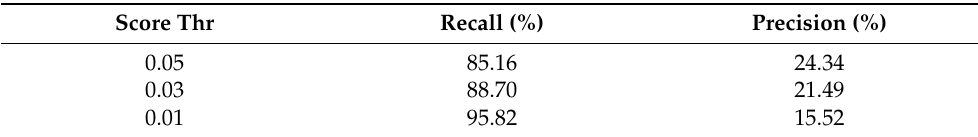
Table 2. Metrics at different score thresholds with Bilinear CNN (ResNet 34) in the first-stage coarse classification